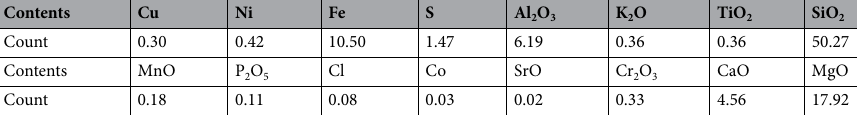
Table 2. Contents of main elements by chemical analysis for Copper-Nickel Sulfide Ores (mass fraction, %).